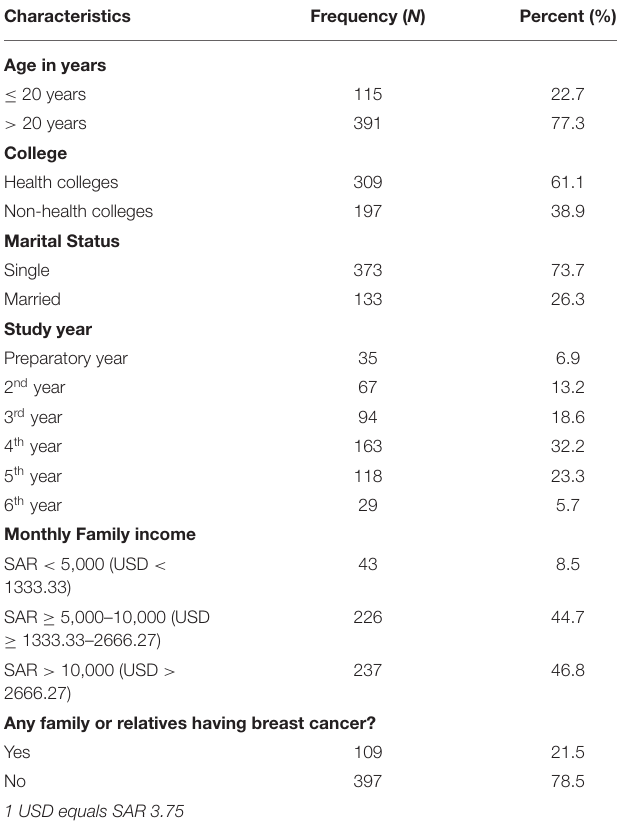
TABLE 1 | Background characteristics of participants ( N = 506).